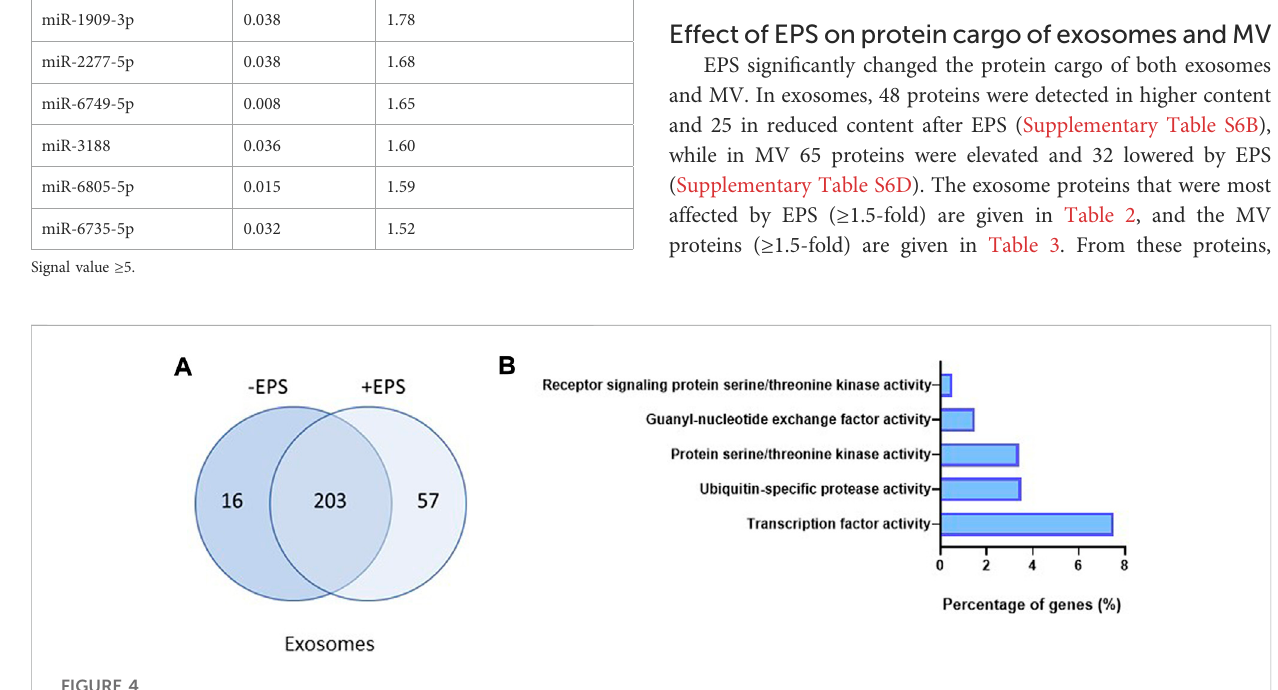
Exosome miRs affected by electrical pulse stimulation (EPS). The number and distribution of miRs present in exosomes before and after EPS (A) . Enrichment analysis of the miRs in exosomes after EPS (performed by FunRich) which shows the predicted molecular functions signi fi cantly associated ( p < 0.05) with the miRs (B)